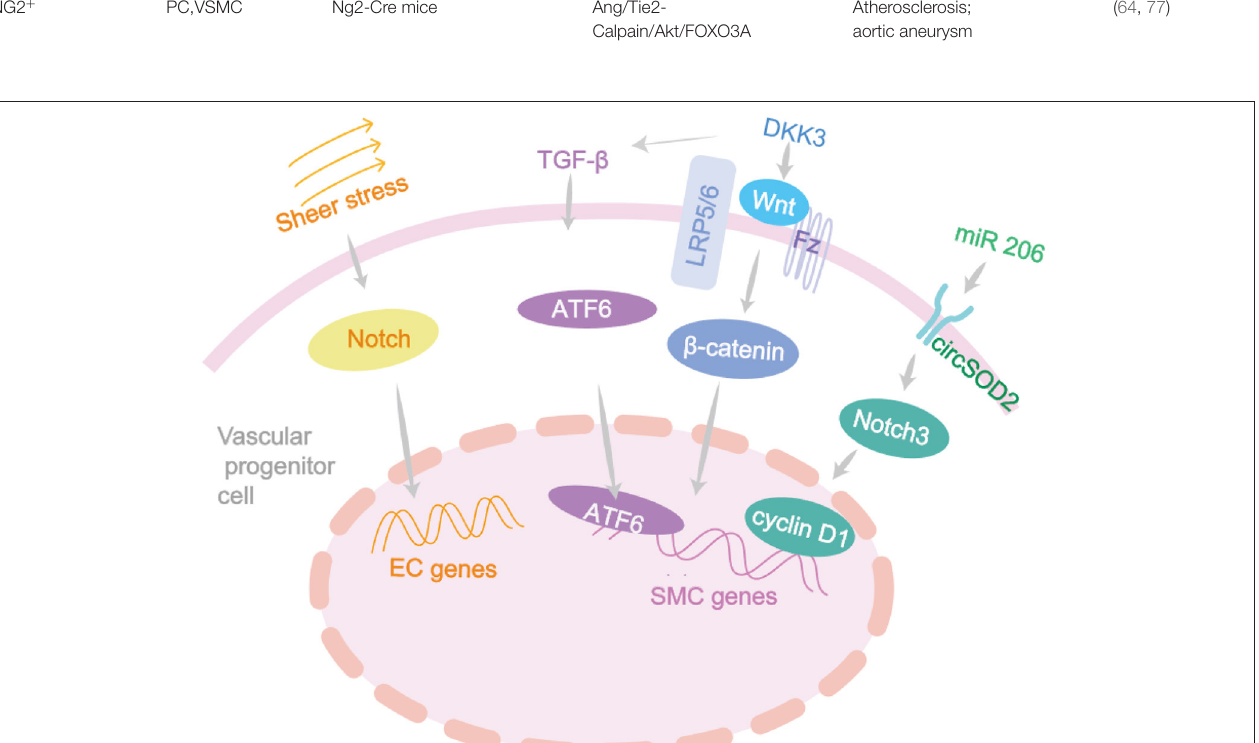
Frontiers in Cardiovascular Medicine |